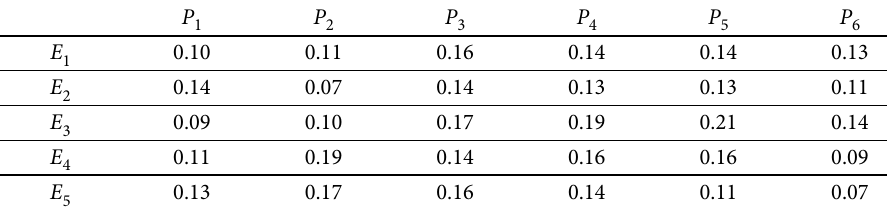
Table 4. Aggregated distances with Hamming